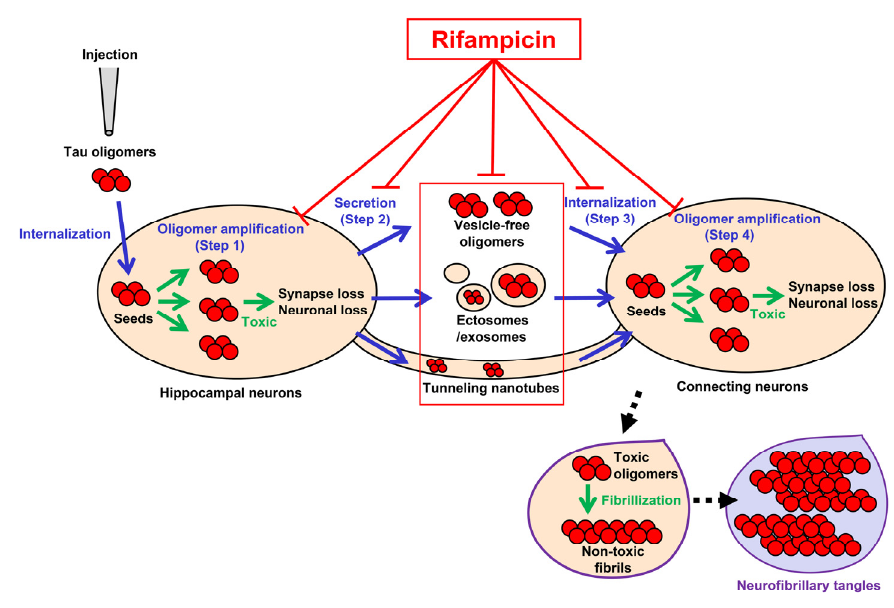
Figure 6. Pathways of tau oligomer propagation and the actions of rifampicin. Injected tau oligomers are internalized to the hippocampal neurons and act as seeds for oligomer amplification (green arrows in step 1). The newly generated tau oligomers are secreted from the cells into the extracellular space as vesicle-free oligomers or in ectosomes/exosomes (step 2). The secreted tau oligomers are internalized to the connecting neurons (step 3). Alternatively, tau oligomers may be transported to neighboring neurons through tunneling nanotubes. The internalized tau oligomers act as seeds for de novo oligomer amplification (green arrows in step 4). Rifampicin has the potential to interfere with all the steps (T-shaped red lines). Tau oligomers are toxic and cause synapse and neuronal loss, while insoluble tau fibrils in neurofibrillary tangles are probably non-toxic. Blue arrows indicate the transmission of tau oligomers. Black arrows with dashed line indicate the process of NFT